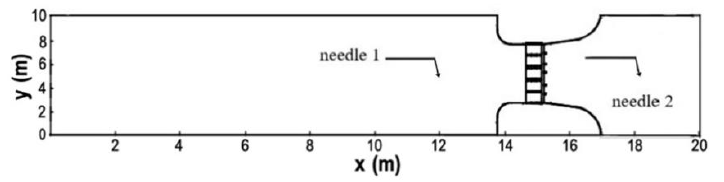
Figure 5. Plan view of the reinforced concrete flume.